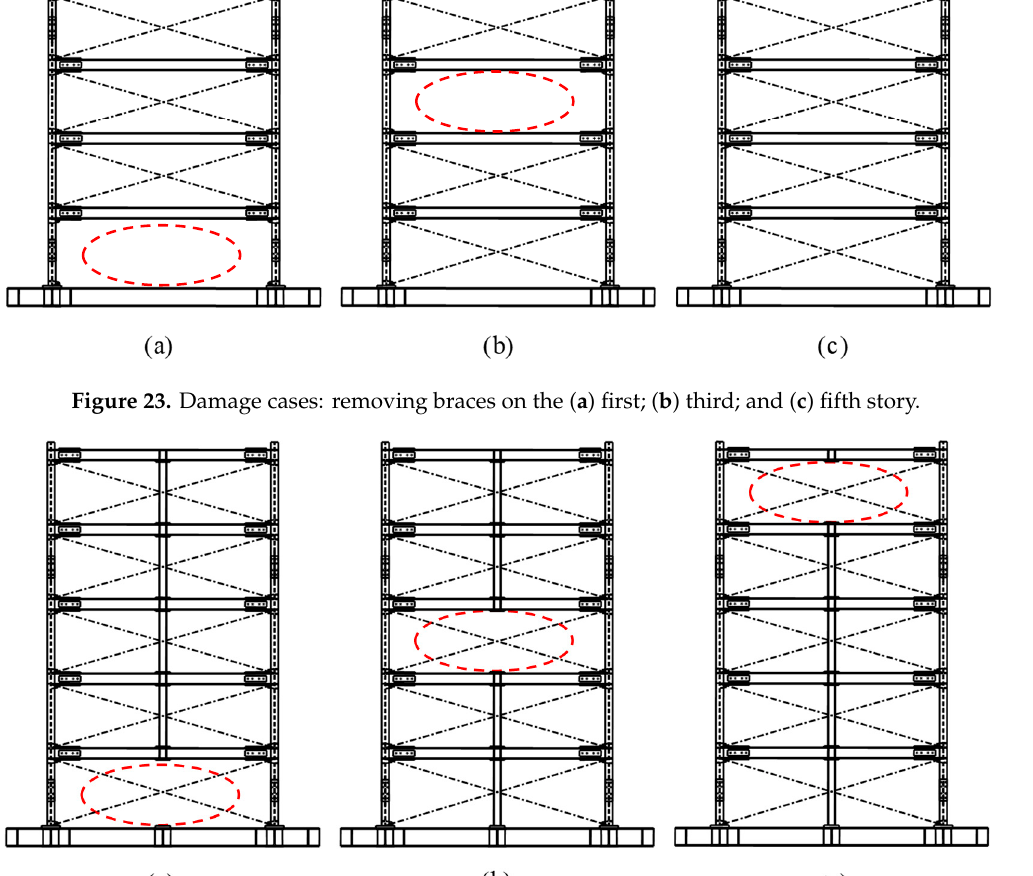
Figure 24. Damage cases: removing central column on the ( a ) first; ( b ) third; and ( c ) fifth story.